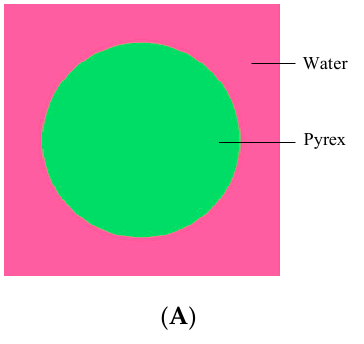
Figure 3. ( A ) Pyrex Rod, ( B ) Fuel Rod.